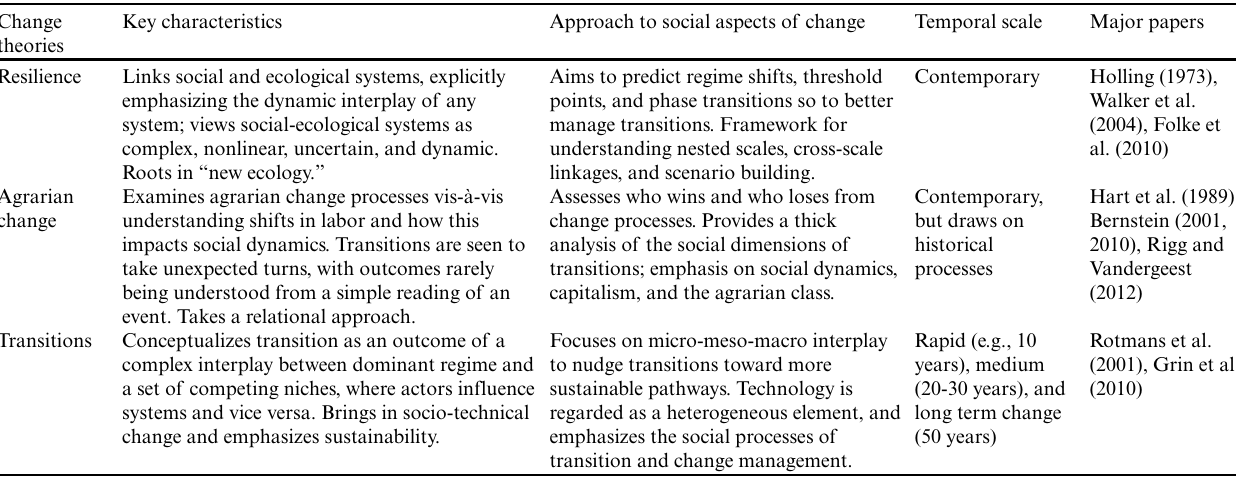
Table 1 . Key characteristics and approach to social aspects of